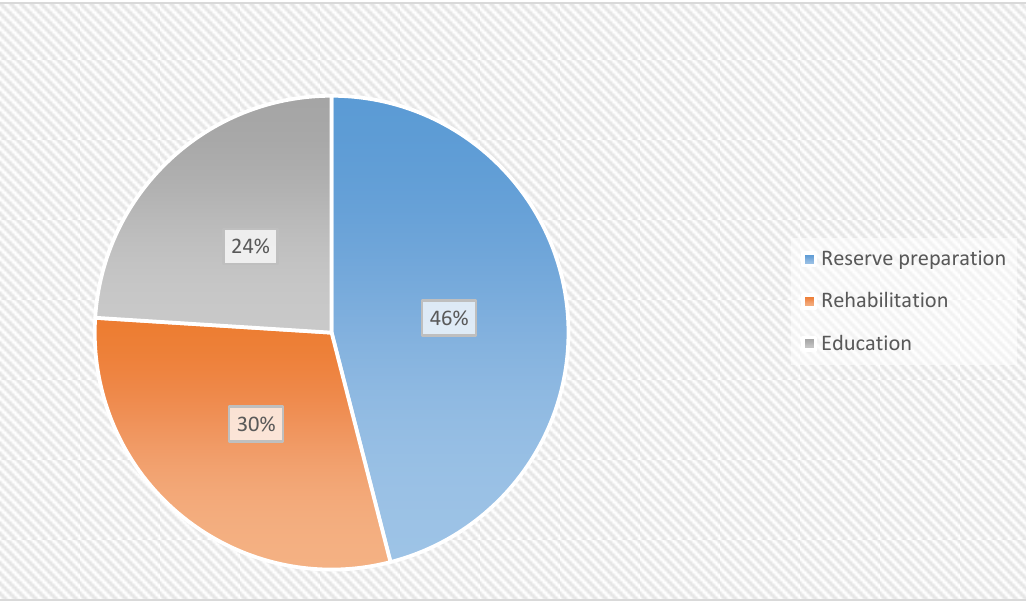
Fig. 1. Youth and reserve sport